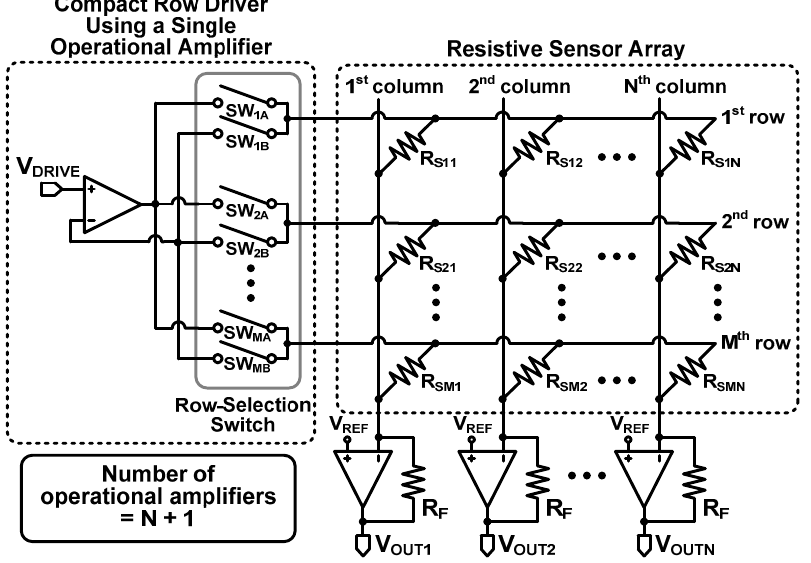
Figure 7. Proposed zero-potential scanning method with the proposed compact row driver using a single operational amplifier (Type III).